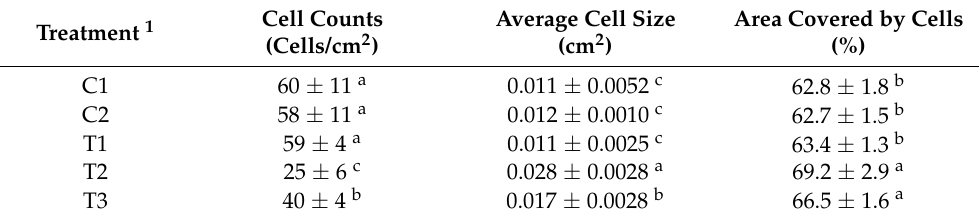
Table 3. Effect of bran incubation and ascorbic acid addition on stickiness of intermediate wheat- grass dough.